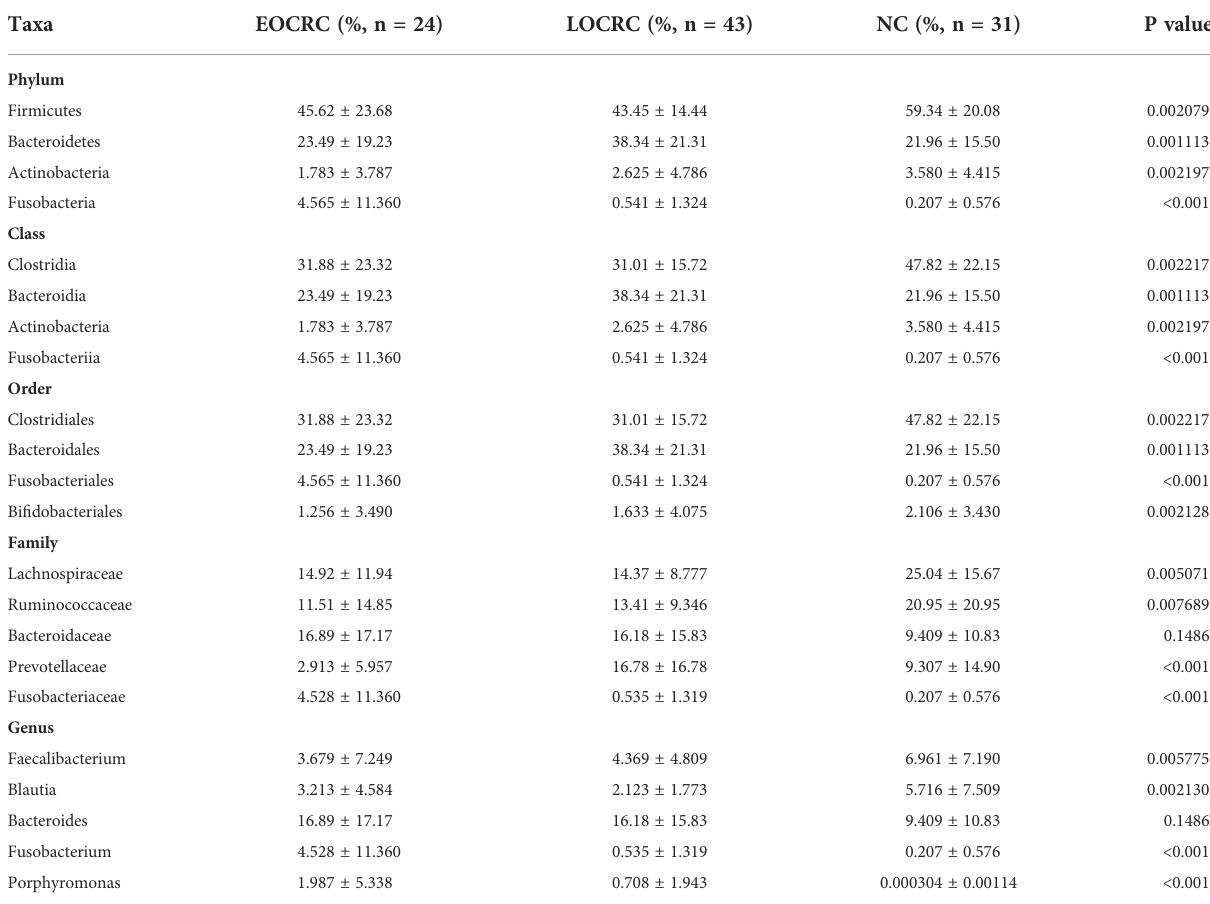
TABLE 2 Taxa differentially represented in the gut microbiota of the three